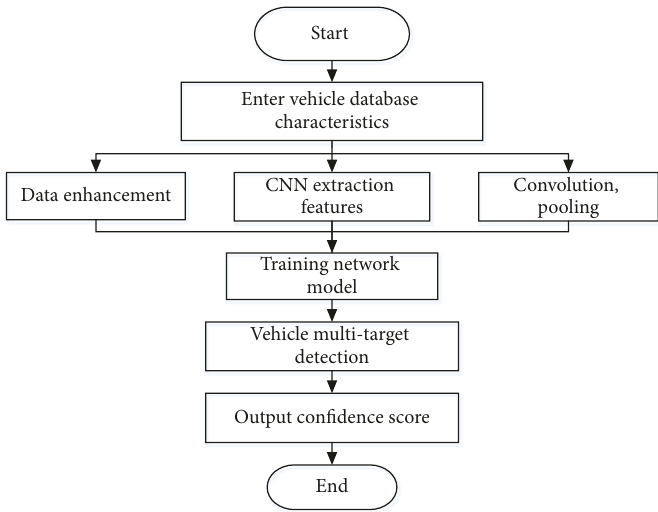
Figure 7: Vehicle detection